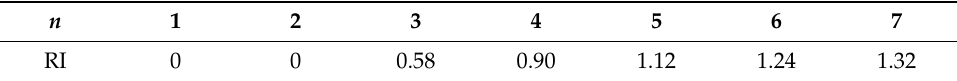
Table 3. Average random consistency